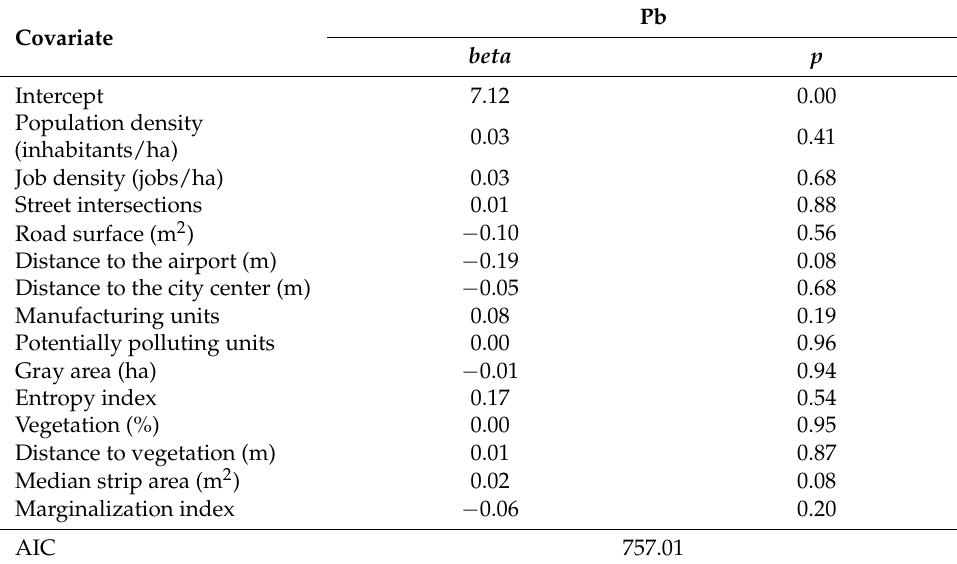
Table 6. Spatial error model results for